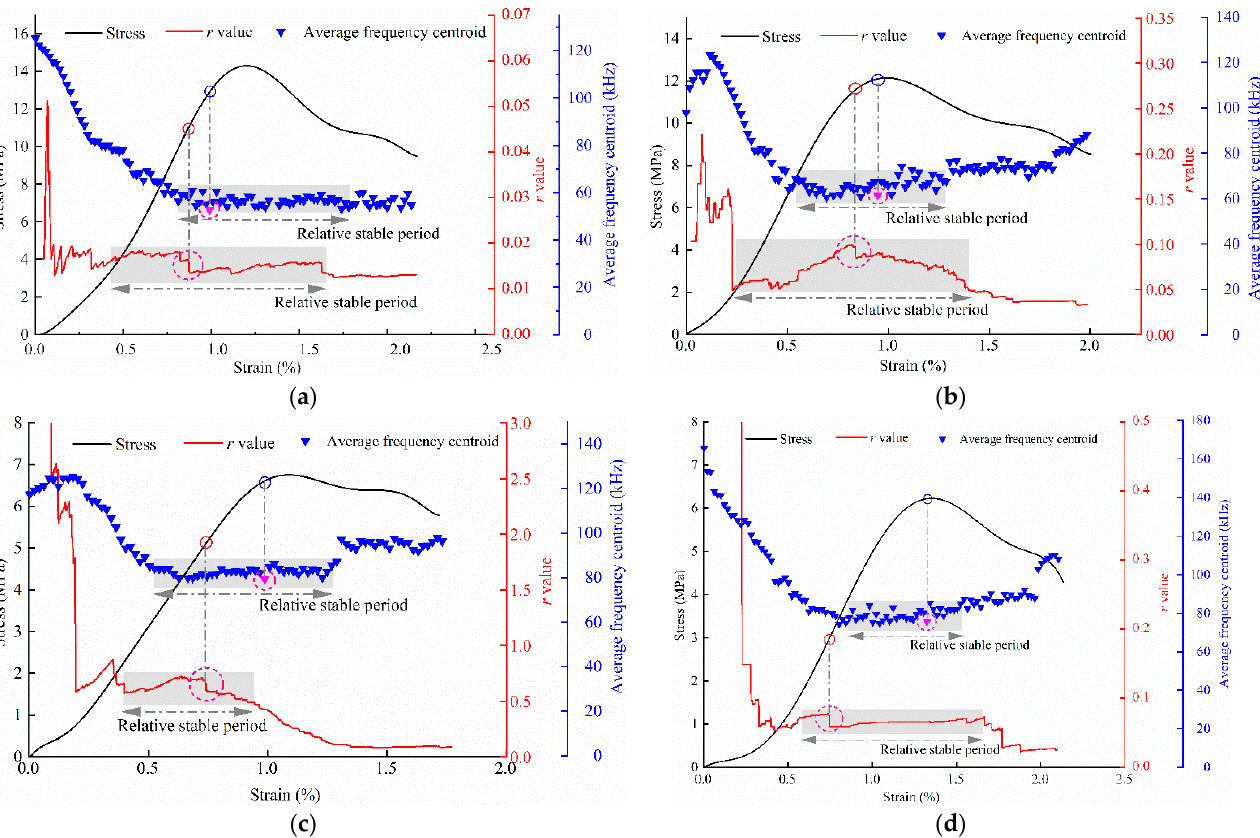
Figure 9. Relationship among AE r value, and stress and strain of backfills with different sizes; ( a ) 40 mm × 40 mm × 40 mm, ( b ) 70.7 mm × 70.7 mm × 70.7 mm, ( c ) 100 mm × 100 mm × 100 mm, ( d ) 150 mm × 150 mm × 150 mm.